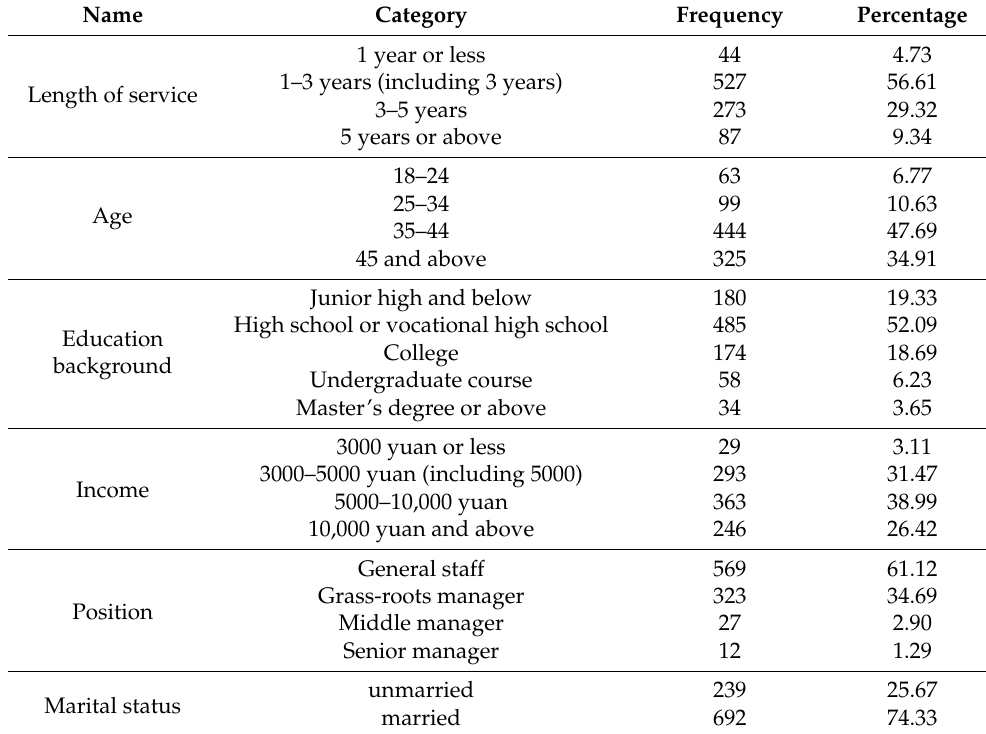
Table 3. Demographic statistical results of valid